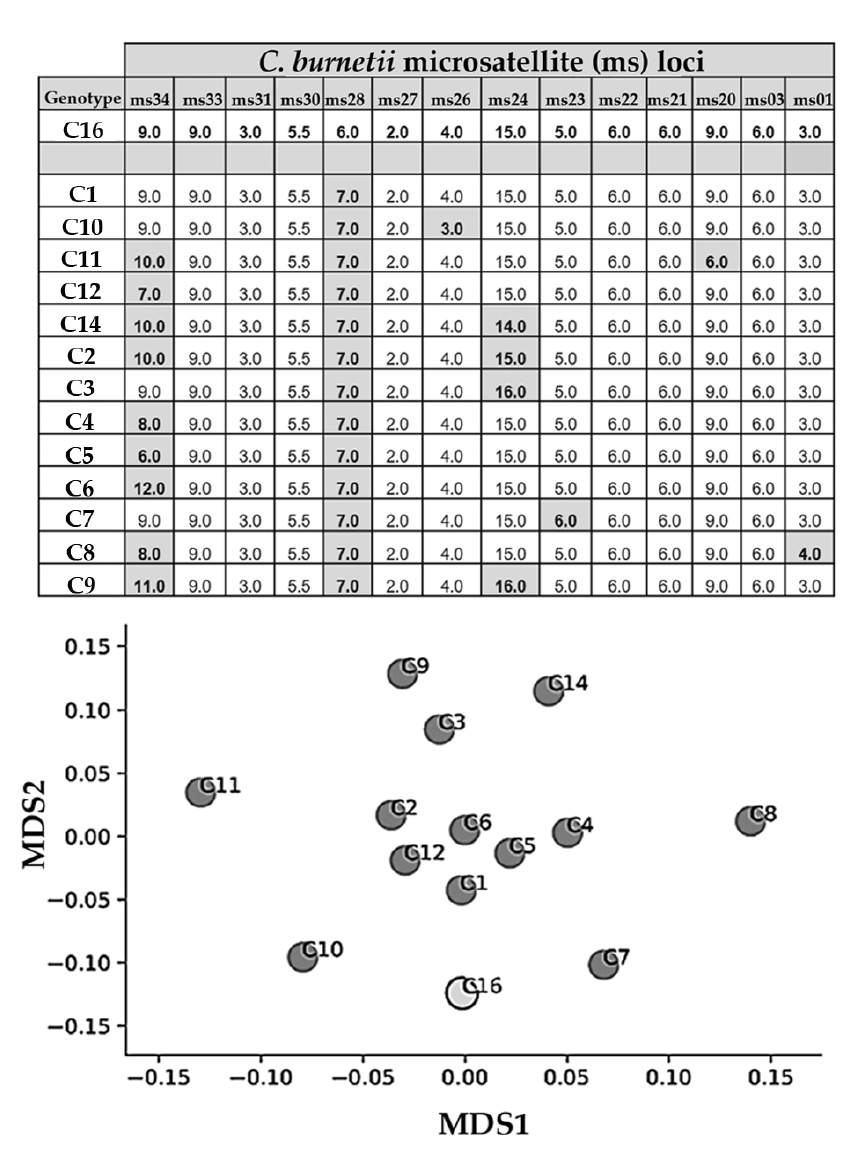
Figure 3. Result-table (top) from the CoxBase-MLVA-query when entering the genotyping profile from this study. For the first time, C16 was identified in bovine and caprine samples, and the next related MLVA-genotypes are C1, C7, and C10. Findings of the performed MLVA/VNTR analyses are depicted for different microsatellites’ (ms) loci (ms34, 33, 31, 30, 28, 27, 26, 24, 23, 22, 21, 20, 03, and 01). Loci from other known Coxiella genotypes, which do not match with the loci of the genotype C16, have a gray background. The multi-dimensional scaling (MDS) plot on the bottom created with Python depicts Jaccard similarity coefficients of the performed microsatellites analysis of the different Coxiella burnetii genotypes.